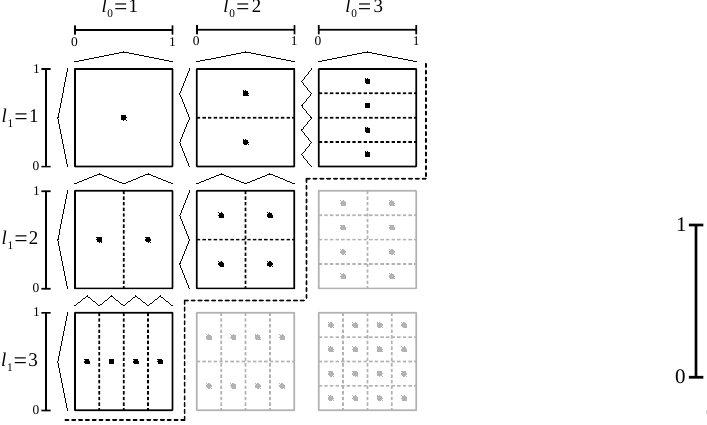
( b ) The 2-D sparse grid (black) obtained by lines outline the support of the basis functions centered superimposing the components grids. at the grid points. Figure 2. The subgrids of a sparse grid with l = 3 (Figure 2a) and the resulting sparse grid (Figure 2b). Greyed out subgrids and grid points would be part of the corresponding full grid.